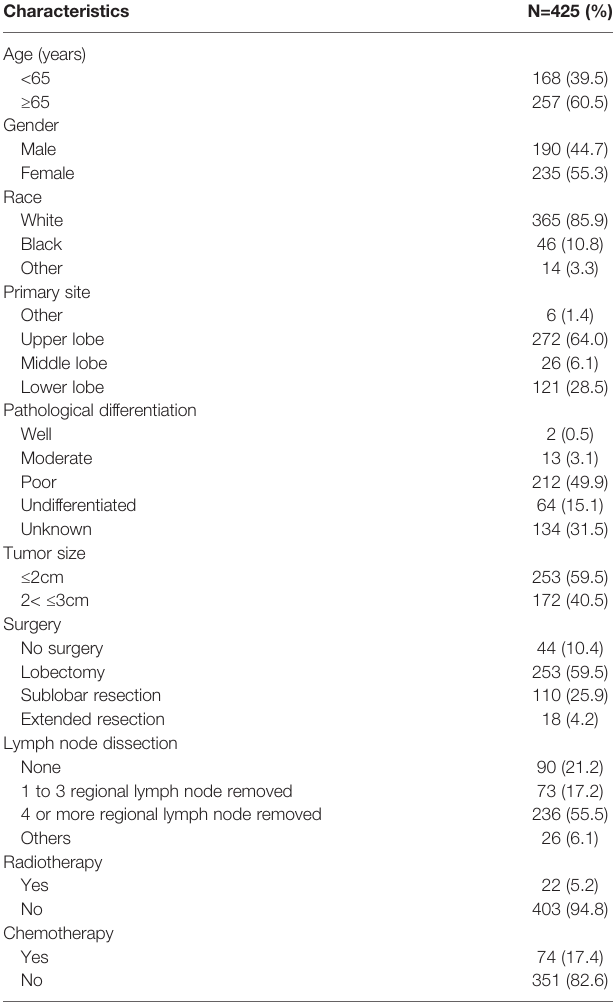
TABLE 1 | Patient